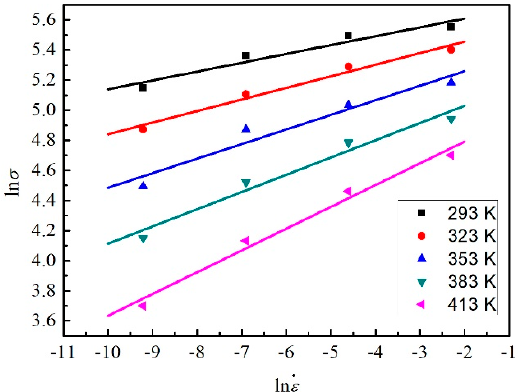
. ε for five temperatures at the strain of